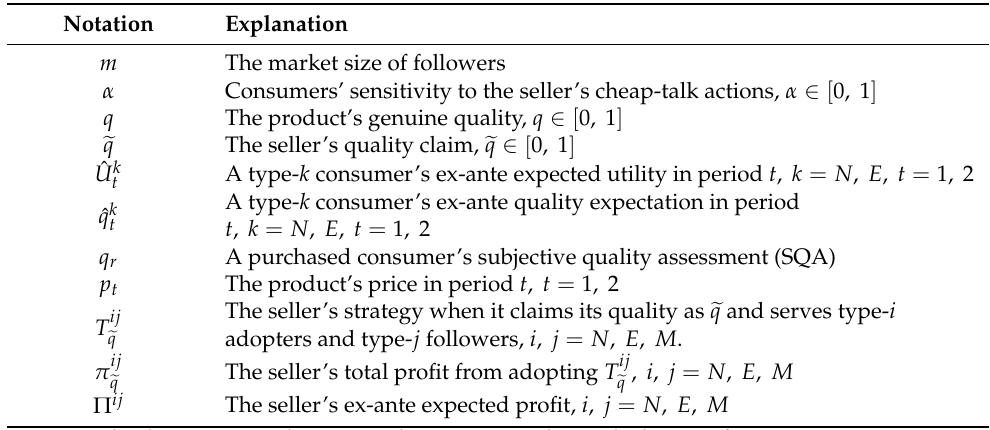
Table 1. Summary of the main